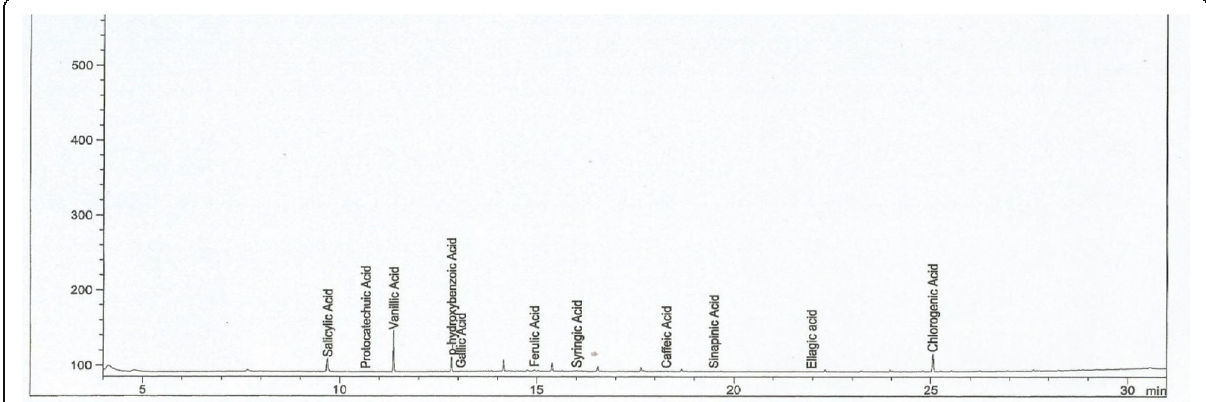
Table 3 Effect of EAFPB on glycated hemoglobin and some antioxidant parameters of fructose overloaded rats Groups